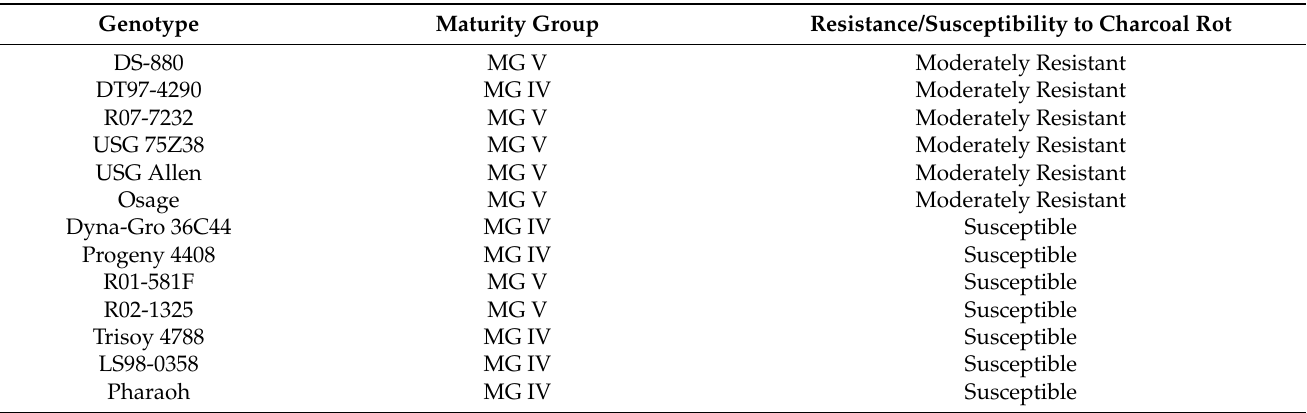
Table 1. Charcoal rot classifications (MR and S) of the thirteen soybean genotypes included in this study, of which six are maturity group (MG) IV and seven are MG V. This table was modified from Mengistu et al.